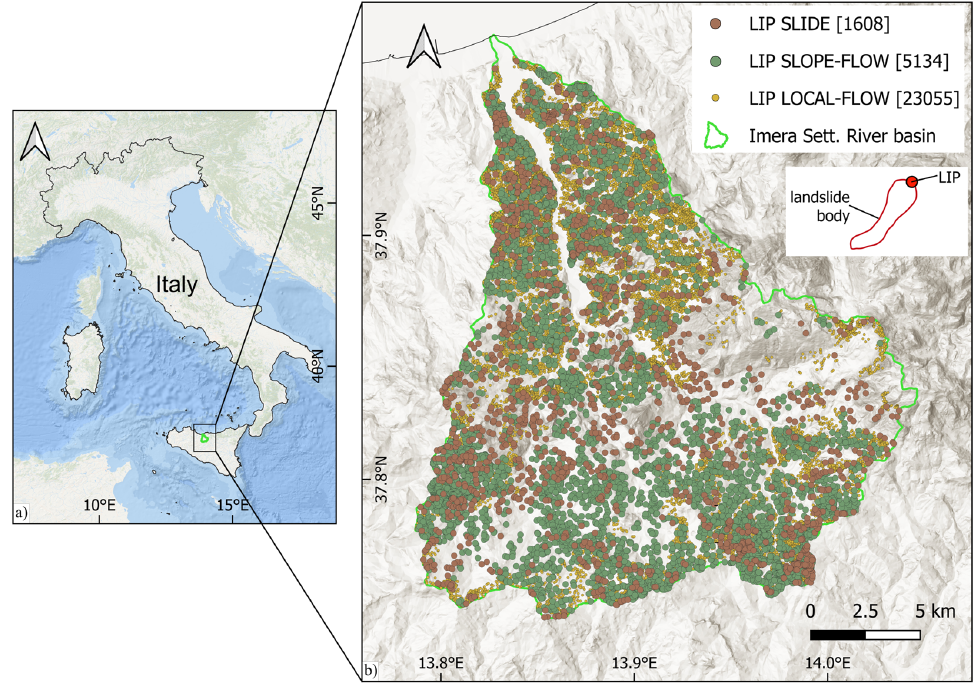
Figure 1. ( a ) Location of the Imera Settentrionale river basin; ( b ) distribution of slide, local-flow and slope-flow LIPs. In square brackets, the count of LIPs is indicated.